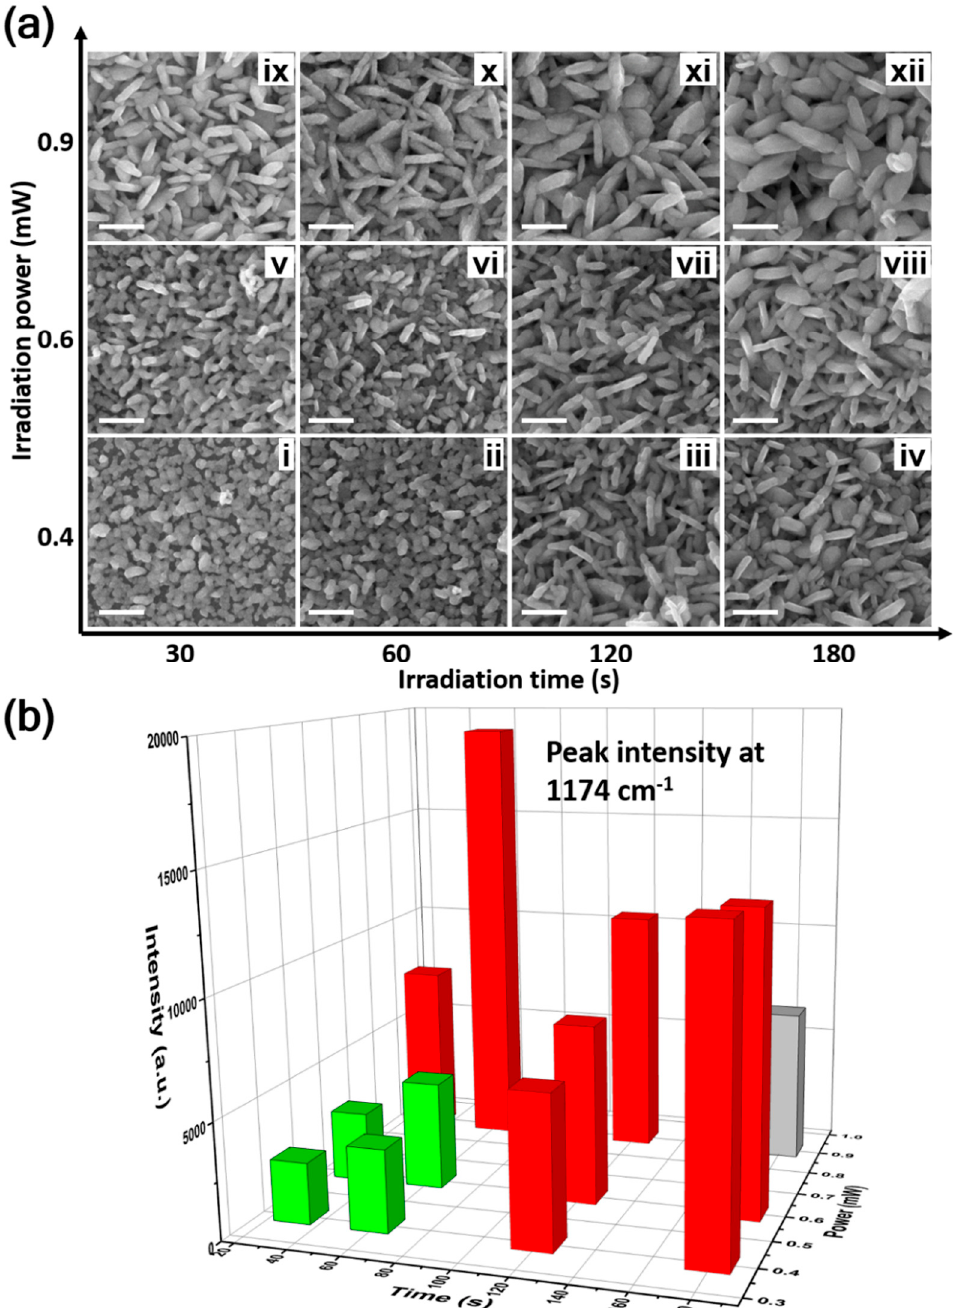
Figure 3. Controlling synthesis of silver aggregates and their SERS activities. ( a ) SEM images of silver aggregates grown under different irradiation power (0.4–0.9 mW) and exposure time (30–180 s). The scale bars are all 500 nm. ( b ) The corresponding SERS intensity from the silver aggregates are shown in ( a ).